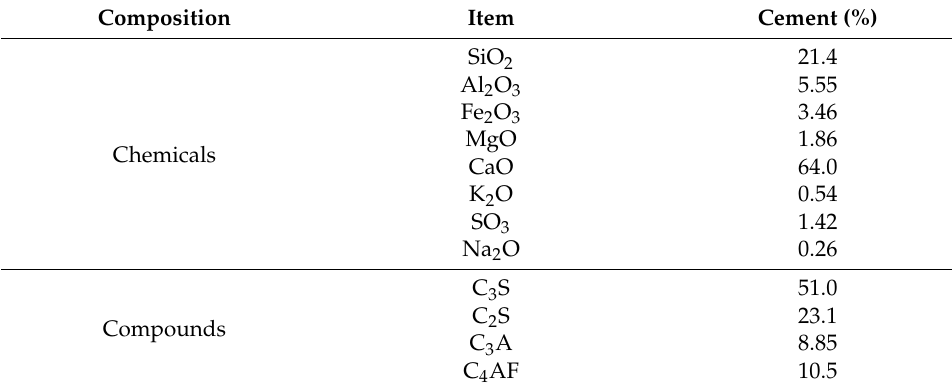
Table 1. Chemical composition and mineral composition of cement.